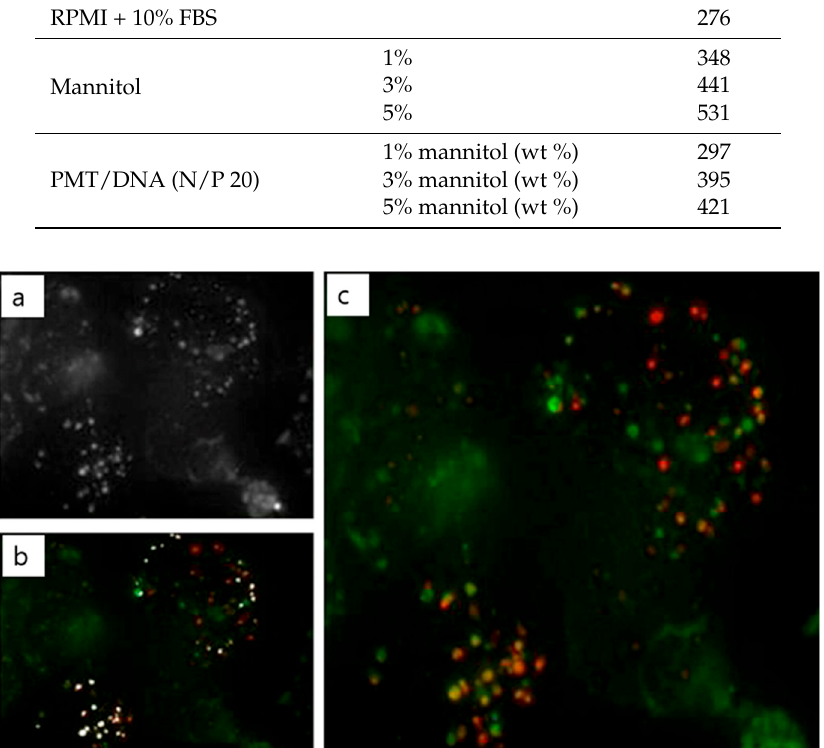
Figure 9. Fluorescent microscopy images showing lysosome staining (red) and FITC-PEI/DNA polyplexes (green); ( a ) Polyplex with FITC ( b ) Colocalization spot using the Image J program; ( c ) overlay of lysosomes and polyplexes (yellow). Scale bar represents 5 μ m. Reproduced with permission from [122]. Copyright proceedings from Elsevier).